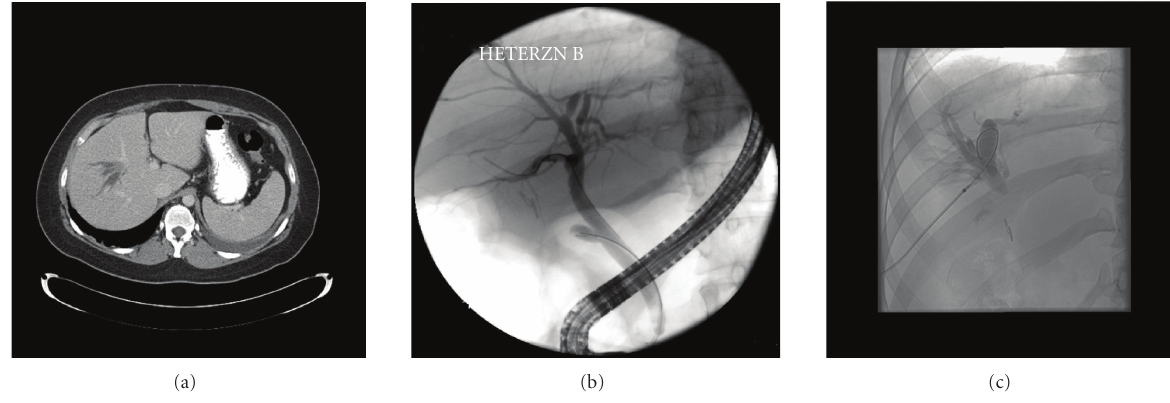
Figure 2: (a) Computed tomography (CT)-scan showing dilated intrahepatic branches in right lobe of liver. (b) Endoscopic retrograde cholangiopancreatography (ERCP) showing paucity of intrahepatic filling in right lobe of liver in an otherwise normal looking ERCP. (c) Percutaneous transhepatic cholangiopancreatography (PTC) showing dilation of intrahepatic branches in the liver segment drained by the aberrant branch isolated by surgical clips.